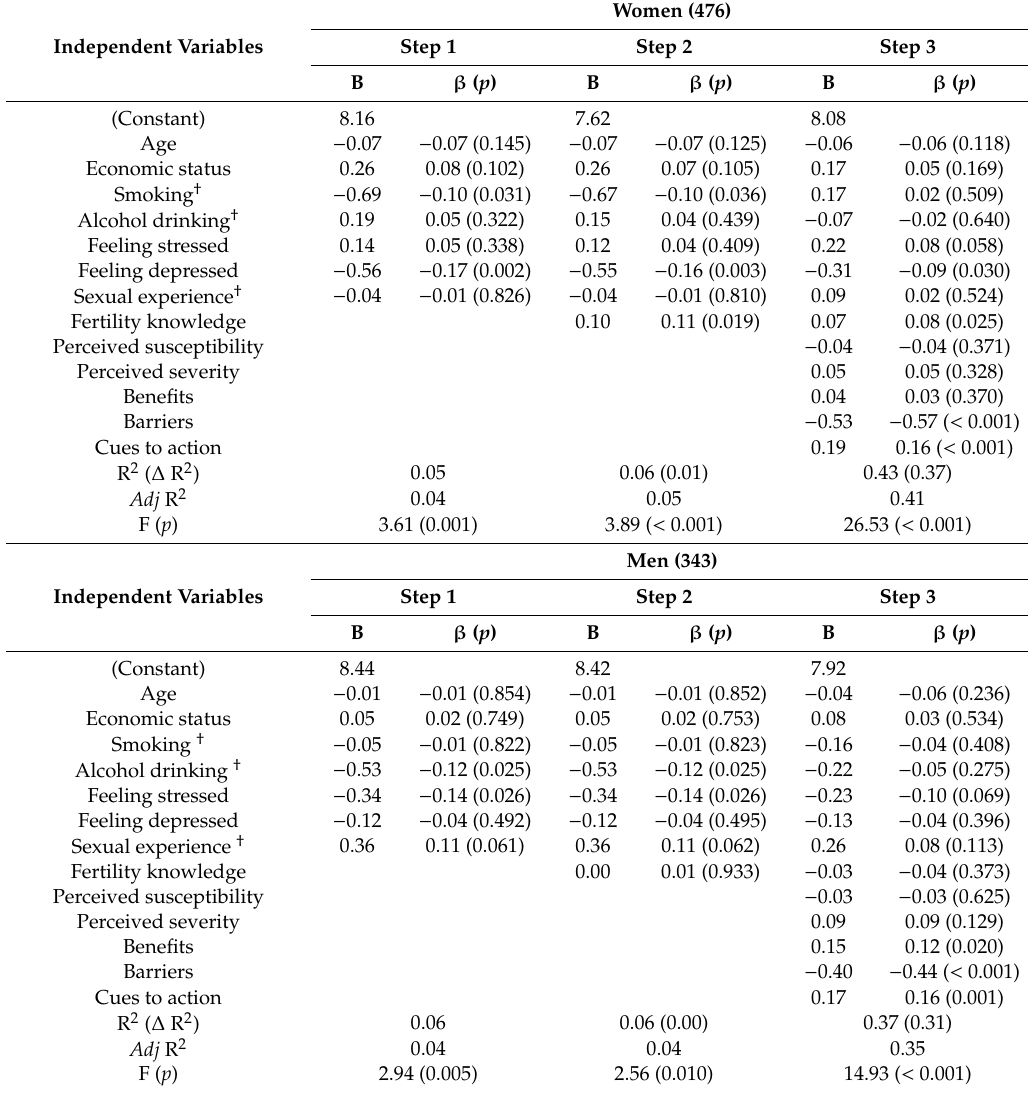
Table 4. Factors influencing self-e ffi cacy toward pregnancy planning by gender ( n = 819).